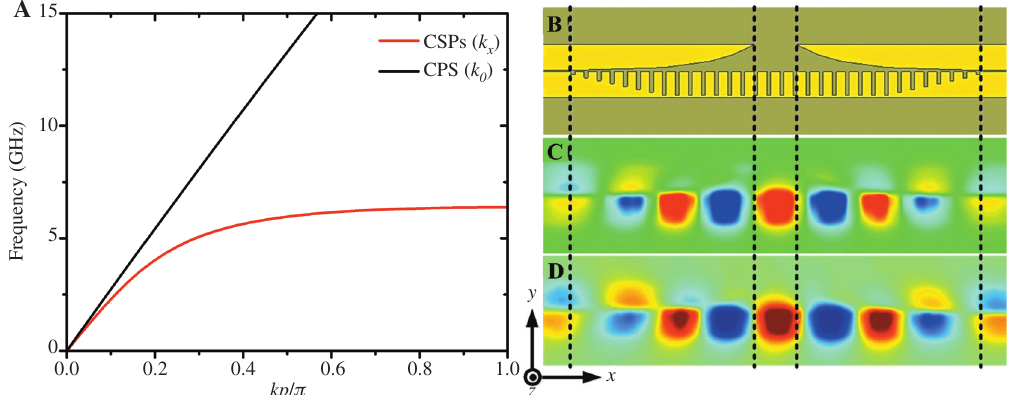
Figure 19: (A) Dispersion curves for the CPS and plasmonic waveguide, in which the red and black solid lines correspond to the CPS and plasmonic waveguide, respectively. (B) The matching transition between the CPS and plasmonic waveguide. (C–D) The simulated and meas- ured E field distributions at 4 GHz, respectively. Reproduced from [45] with z